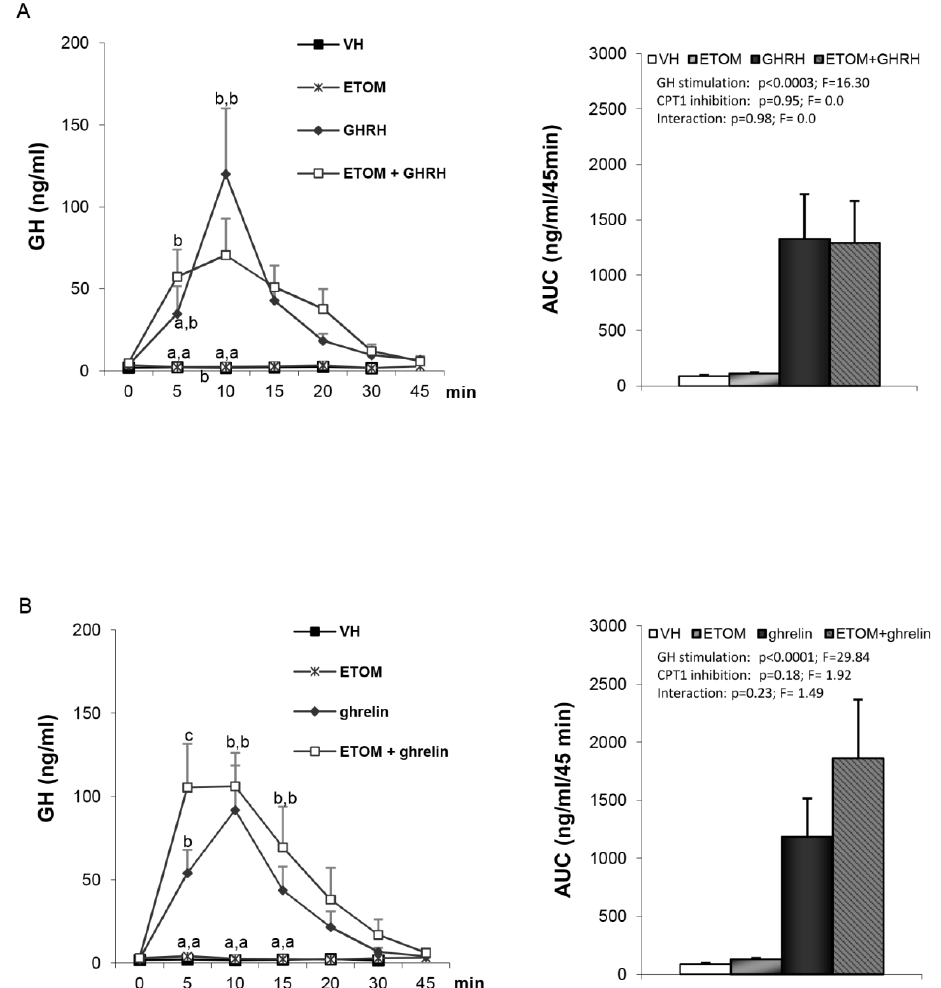
Figure 3. Serum GH profile and area under the curve (AUC) over the study period (45 min) after the administration of: Panel ( A ) VH (5 µL DMSO icv plus 200 µL saline iv), ETOM (10 µg etomoxir icv plus 200 µL saline iv), GHRH (5 µL DMSO icv plus 12 nmol/kg GHRH iv) or ETOM+GHRH (10 µg etomoxir plus 12 nmol/kg GHRH iv). Panel ( B ) VH (5 µL DMSO icv plus 200 µL saline iv), ETOM (10 µg etomoxir icv plus 200 µL saline iv), ghrelin (5 µL DMSO icv plus 12 nmol/kg ghrelin iv) or ETOM + ghrelin (10 µg etomoxir icv plus 12 nmol/kg ghrelin iv). Administration of the peptides took place after stabilization of the animals following the third sampling point (indicated as time 0). Values are given as the mean ± SEM. p < 0.05; two-way ANOVA repeated measures followed, in case of hormone profile, by a post hoc Bonferroni’s test (groups with different superscript letters are statistically different). 3.3. Hypothalamic mTOR is not Involved in GHRH- and Ghrelin-Stimulated GH Secretion It is well established that mTOR signaling at discrete hypothalamic neuronal populations plays an important role in energy homeostasis and has been shown to be a mediator of leptin’s anorexigenic effects [24,25]; a hormone that is also involved in the control of GH secretion [26]. Thus, we assessed whether central inactivation of mTOR by rapamycin may influence GH secretion. We found a similar response to either GHRH (Figure 4A) or ghrelin (Figure 4B) in vehicle- and rapamycin-treated rats. Likewise, GnRH-induced LH secretion was not affected by the inactivation of central mTOR signaling by rapamycin (Figure 5).